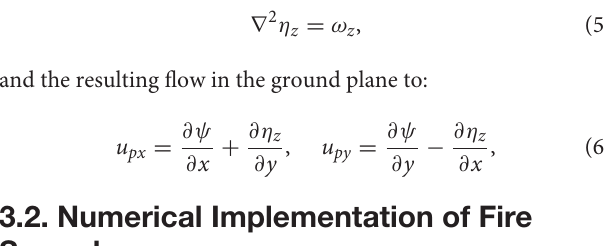
source term was a single point with ω z = 5 at the indicated u a = 0. The resolution was set to 1 m and run for 200 s.